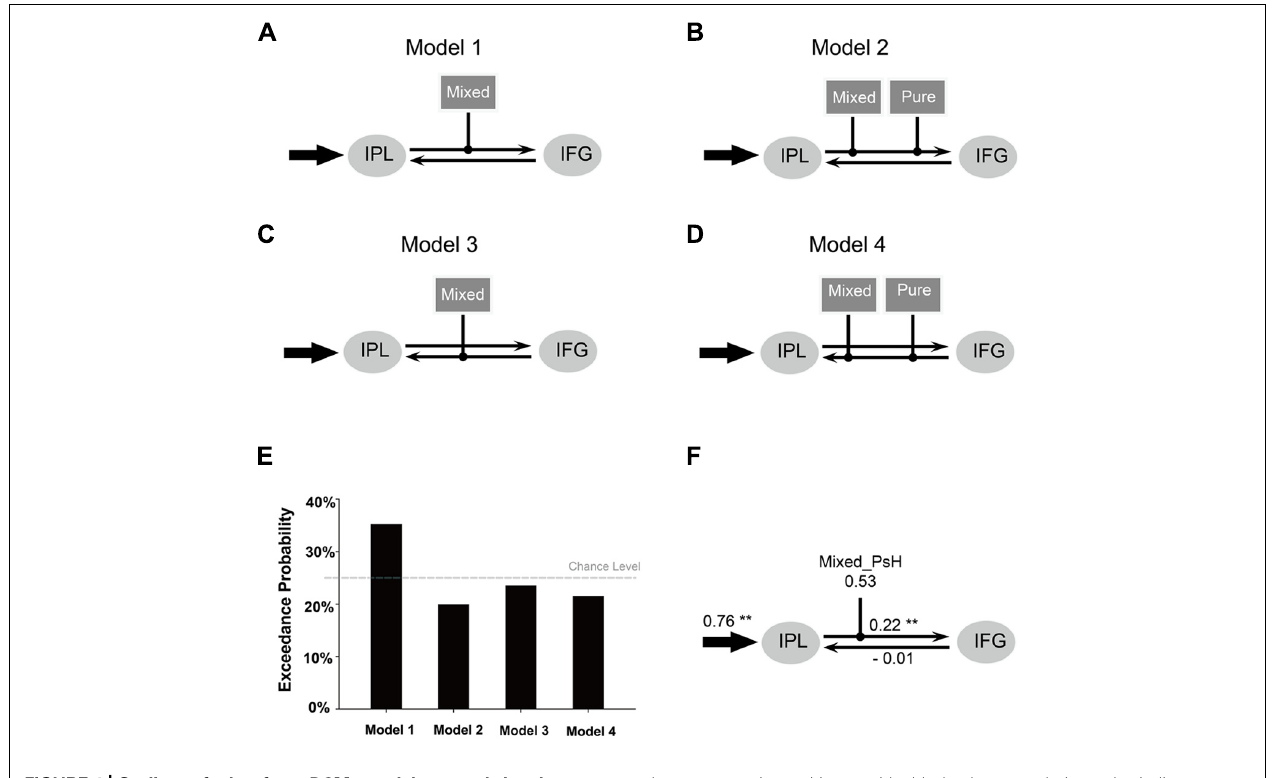
FIGURE 4 | Outline of the four DCM models tested in the present study. (A–D) Results of Bayesian Model Selection (E) . The estimated DCM parameters of the winning model (F) . Arrows represent driving input into regions, or intrinsic connections